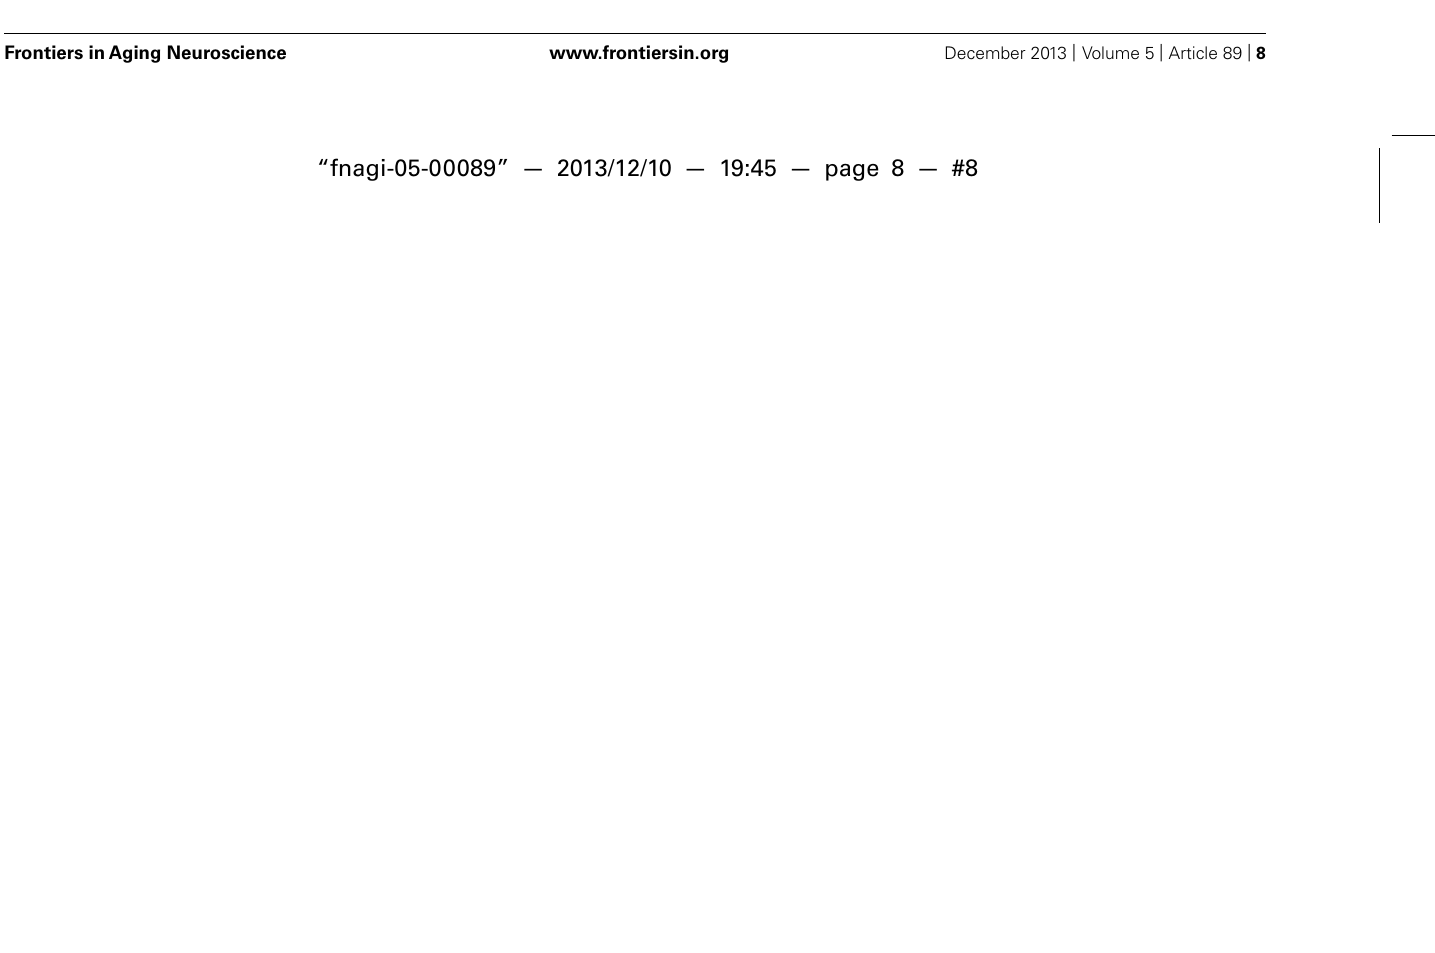
topographic maps are displayed on the right with electrode cluster used for analysis indicated. Each head map represents 100 ms average and color voltage scale is